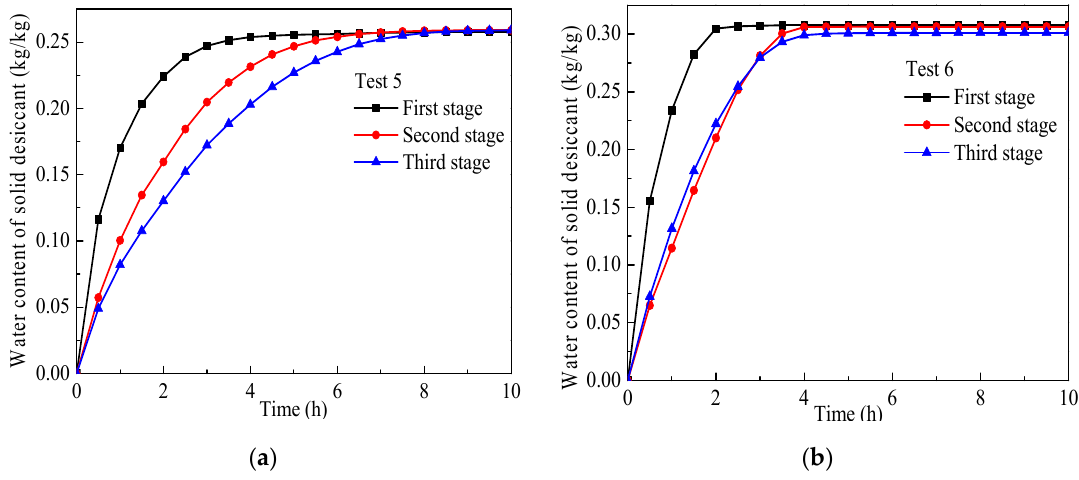
Figure 10. Variation of water content of each stage with time: ( a ) without internal cooling; ( b ) with internal cooling.